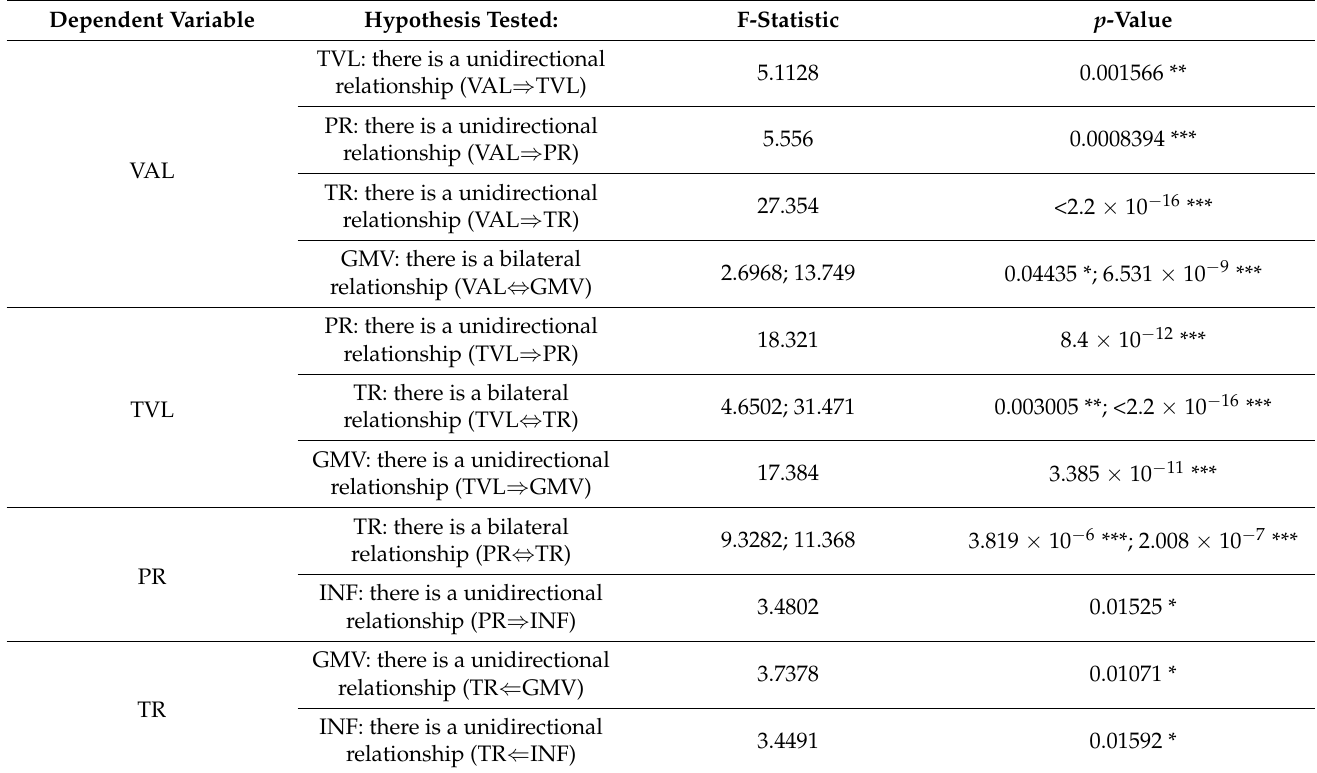
Table 7. Pairwise Granger causality